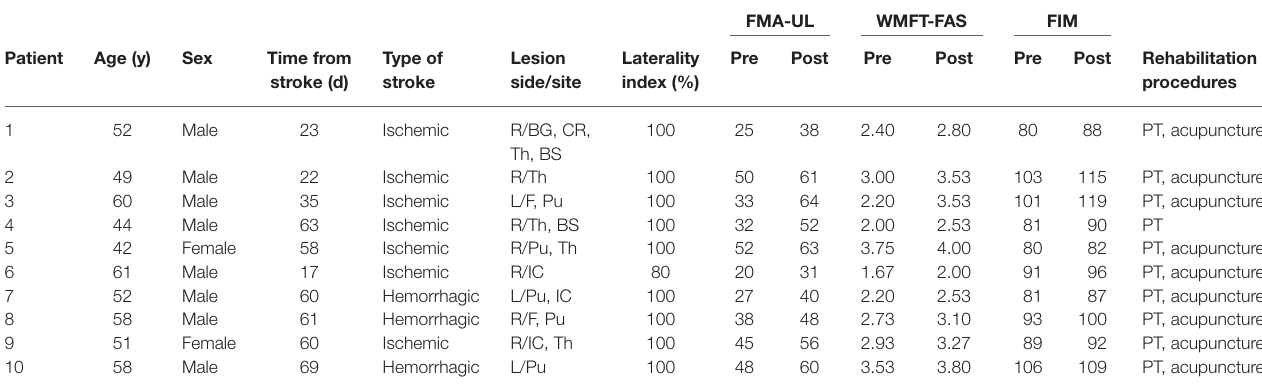
Abbreviations: R, right hemisphere lesion; L, left hemisphere lesion; BG, basal ganglia; CR, corona radiate; Th, thalamus; BS, brain stem; IC, internal capsule; P, putamen; F, frontal; FMA-UL, the Fugl-Meyer Assessment-upper limb; WMFT-FAS, the Wolf Motor Function Test-functional ability scores; FIM, the Functional Independence Measure; PT, physical